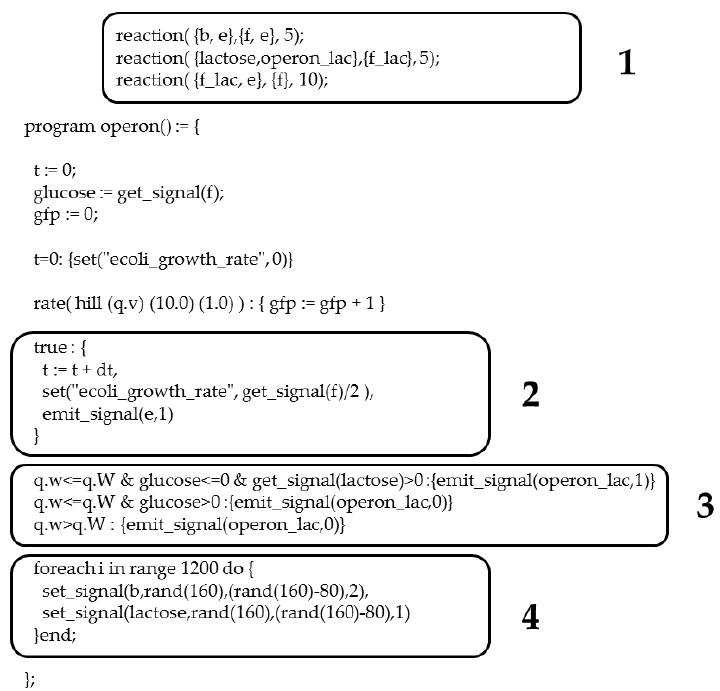
Figure A1. Antibiotic selection routine implemented in Gro language for the 0/1 knapsack problem. The code shows q.w or weight of the knapsack and q.W, which is the maximum capacity (weight) of the knapsack. ( 1 ) Conditional sentence of the antibiotic resistance. ( 2 ) Antibiotic signal randomly distributed in the environment where the colony of synthetic bacteria grows.